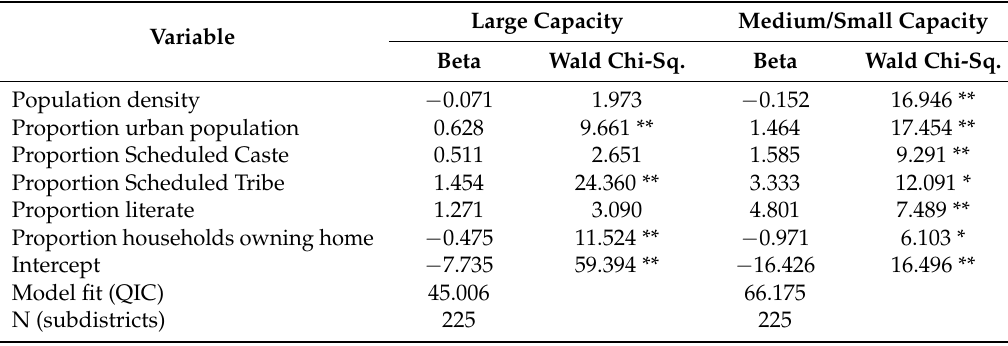
Table 4. GEEs for predicting density of MAH units by capacity.